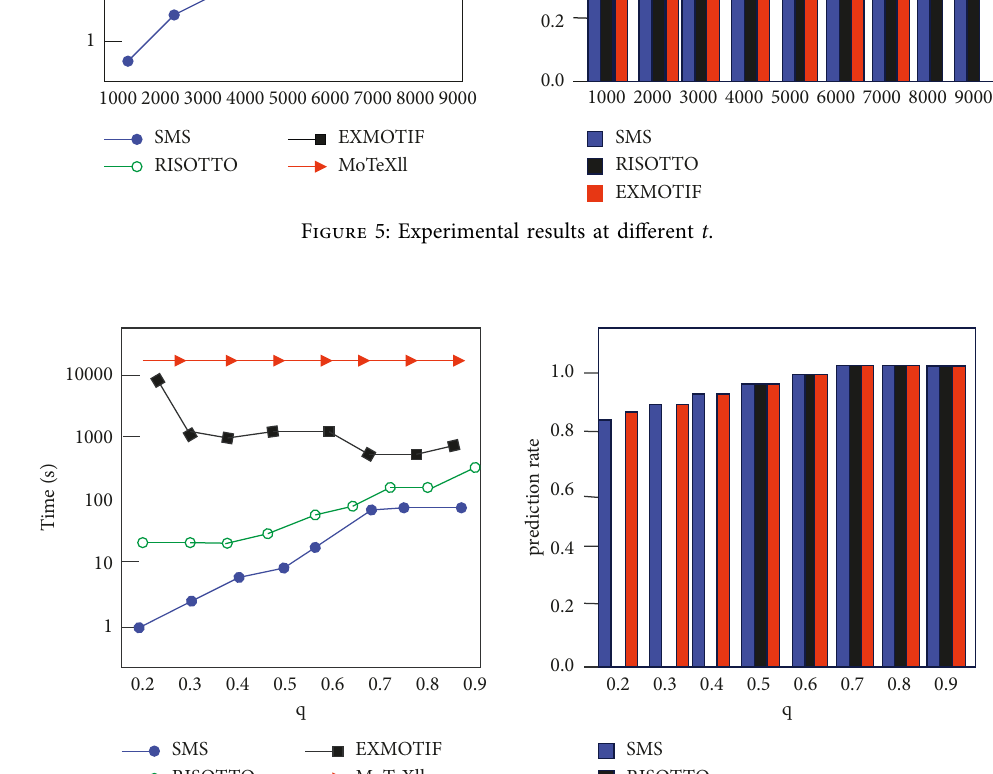
Figure 6: Experimental results on different q